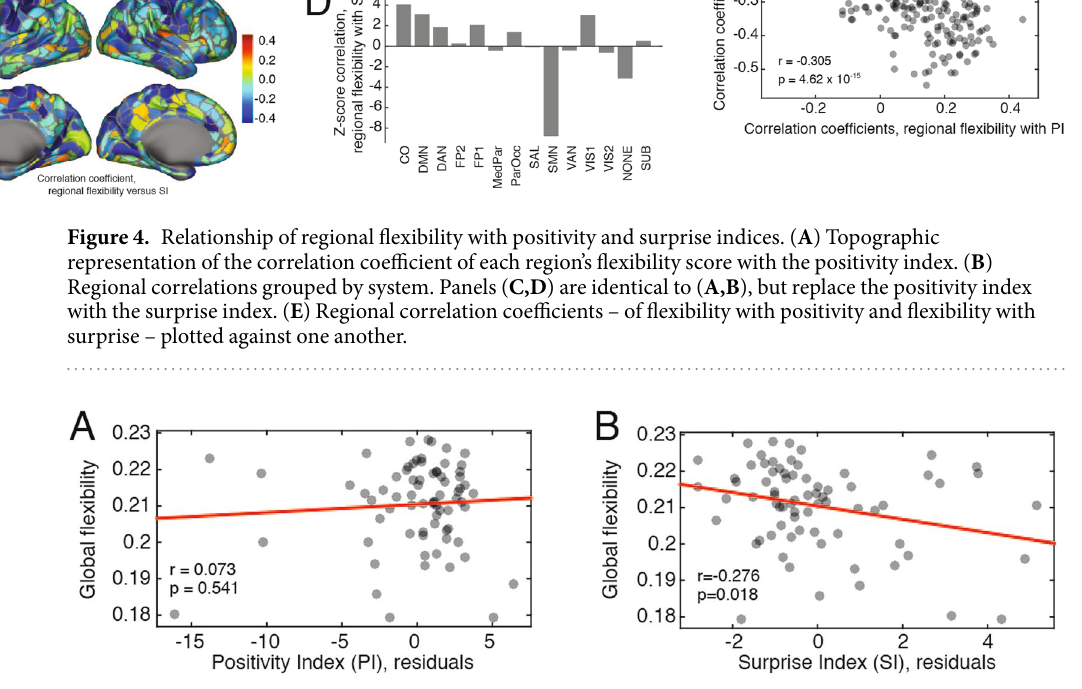
Figure 5. Correlation of positivity and surprise indices after controlling for fatigue. ( A ) Scatterplot of global flexibility with residuals of the positivity index after regressing out fatigue. ( B ) Scatterplot of global flexibility with residuals of the surprise index after regressing out